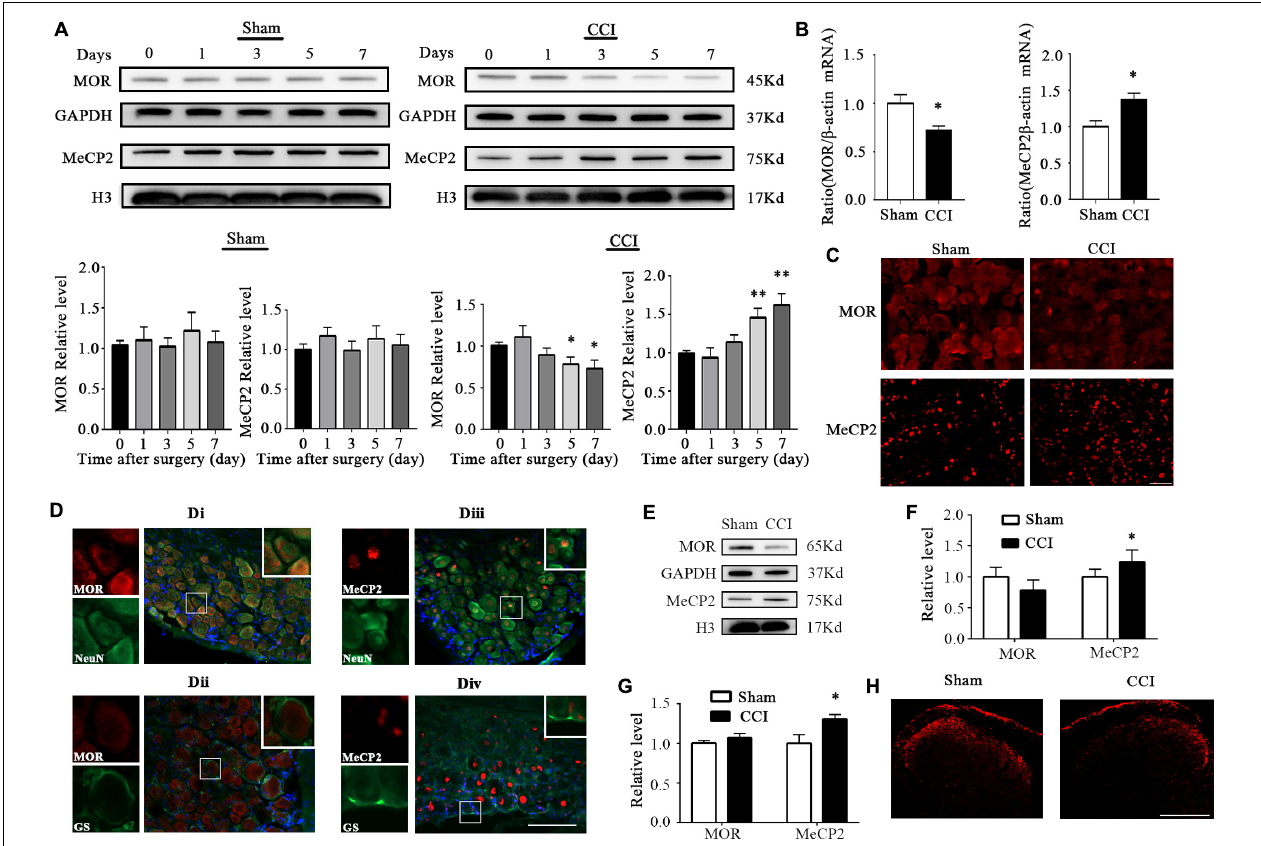
FIGURE 1 | MOR expression was decreased and MeCP2 was increased 7 days after CCI surgery in the injured DRG. (A) MOR and MeCP2 protein expression in the ipsilateral L3–5 DRG 7 days after CCI or sham surgery. n = 6 biological repeats (18 mice)/time point/group. One-way ANOVA followed by post hoc Tukey test. F group (4, 25) = 1.621 for MOR in the sham group, F group (4, 25) = 2.544 for MeCP2 in the sham group, F group (4, 25) = 2.728 for MOR in the CCI group, F group (4, 25) = 6.967 for MeCP2 in the CCI group. * p < 0.05, ** p < 0.01, versus day 0 in the CCI group. (B) MOR and MeCP2 mRNA expression in ipsilateral DRG 7 days after surgery. n = 4 biological repeats (8 mice)/group. * p < 0.05, versus the sham group by two-tailed unpaired Student’s t -test. (C) Representative images of MOR immunofluorescence in the injured DRG. MOR immunoreactivity was lower on the ipsilateral injured side of the DRG, compared with the level in sham DRG 7 days after CCI. Scale bar: 100 µ m. n = 3 mice/group. (D) Neurons/gliocytes labeled by MOR/MeCP2 and NeuN/GS in the ipsilateral DRG of naïve mice. Nuclei were stained with DAPI. Scale bar: 100 µ m. n = 3 mice/group. (E) MOR and MeCP2 protein levels in L3–5 spinal cord of the injured side 7 days after surgery. n = 6 biological repeats (6 mice)/group. (F) Quantification of MOR and MeCP2 protein expression of panel (E) . * p < 0.05, versus the corresponding sham group by two-tailed unpaired Student’s t -test. (G) MOR and MeCP2 mRNA levels in L3–5 spinal cord on the injured side 7 days after surgery. n = 4 biological repeats